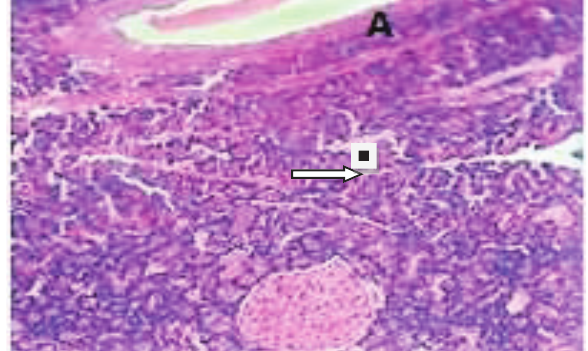
Fig-5: Group A (normal control) Histology of pancreas showing normal islets of Langerhans (40 x; H&E)